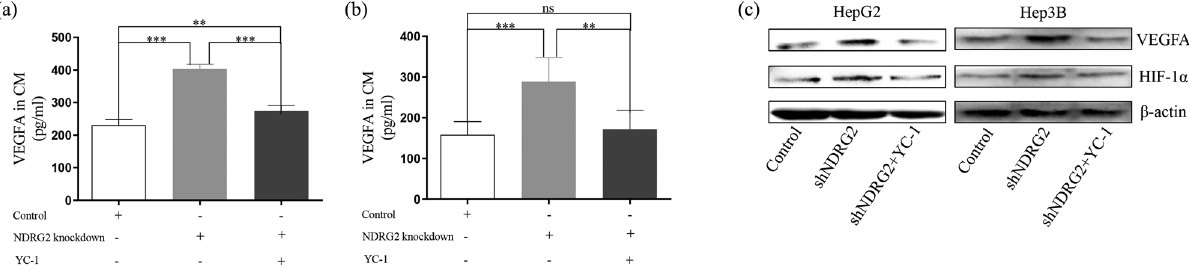
Figure 4: HIF - 1 α is needed in the NDRG2 - VEGFA inducing angiogenesis. HIF - 1 α inhibitor YC - 1 was used to evaluate the e ff ect of NDRG2 on the VEGFA expression. ( a – b ) YC - 1 signi fi cantly inhibited the levels of VEGFA in CM from NDRG2 knockdown cells. ( c ) That YC - 1 inhibited the expression of VEGFA and HIF - 1 α was con fi rmed by the western blot. ns, no signi fi cance; ** P < 0.01; *** P <